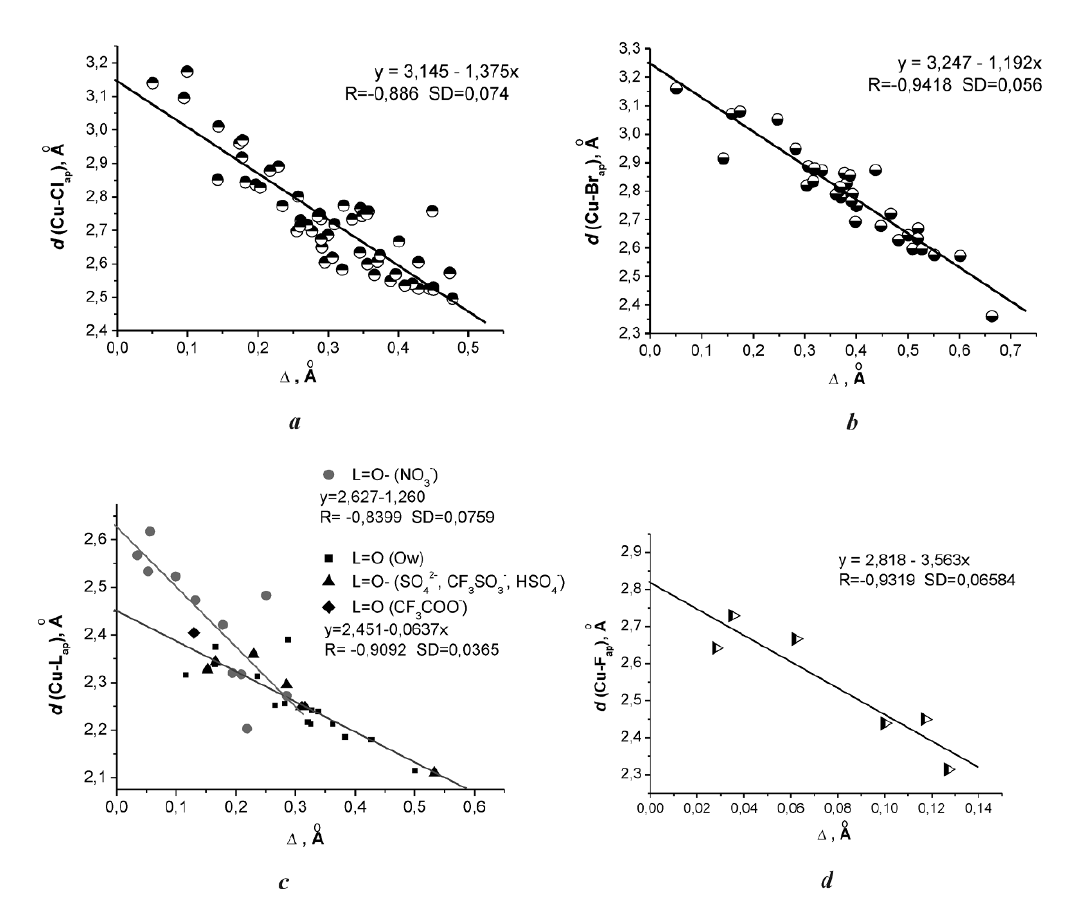
Figure 1. Plot of Δ versus d (Cu-L (for 32 compounds), d - L